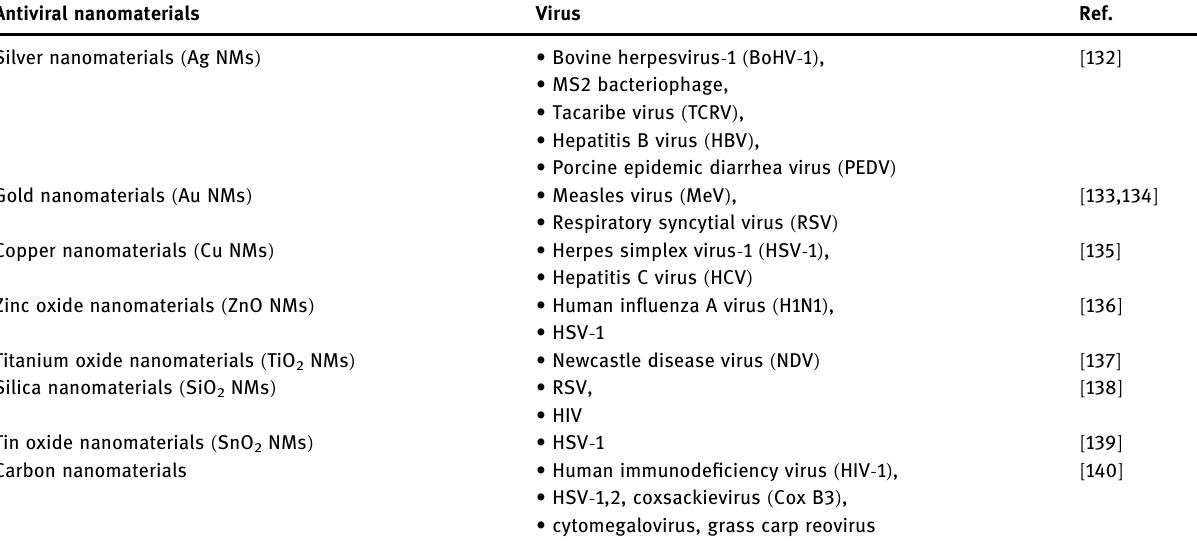
Table 3: Membrane antiviral nanomaterial additives Antiviral nanomaterials Virus Ref.